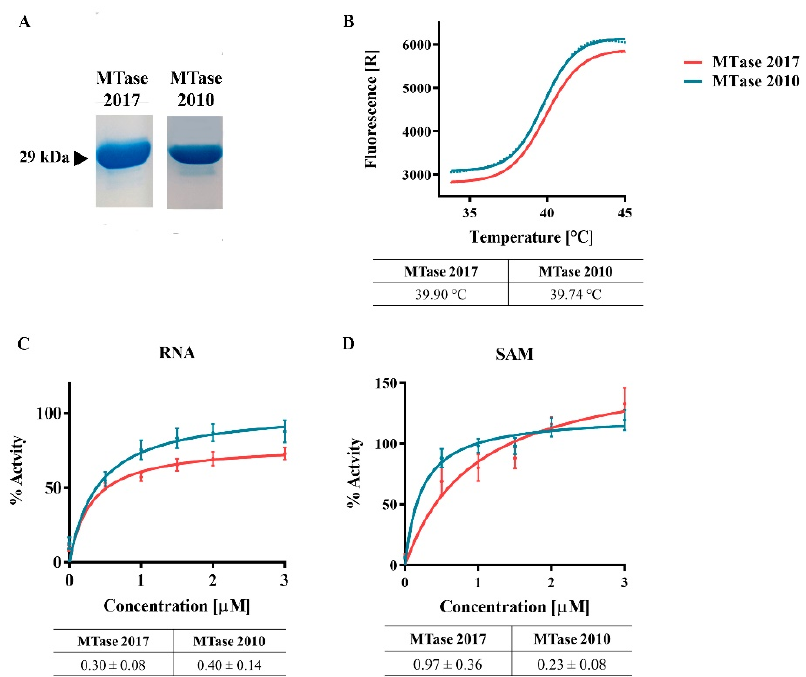
Figure 8. MTase expression and activity. ( A ) SDS-PAGE of purified proteins MTase 2017 and MTase 2010. ( B ) Thermal shift assay of the two MTase variants, with their respective melting temperature. ( C , D ) Michaelis-Menten curve fit of MTase activities and the Km values using varying concentrations of RNA or SAM ( D ).